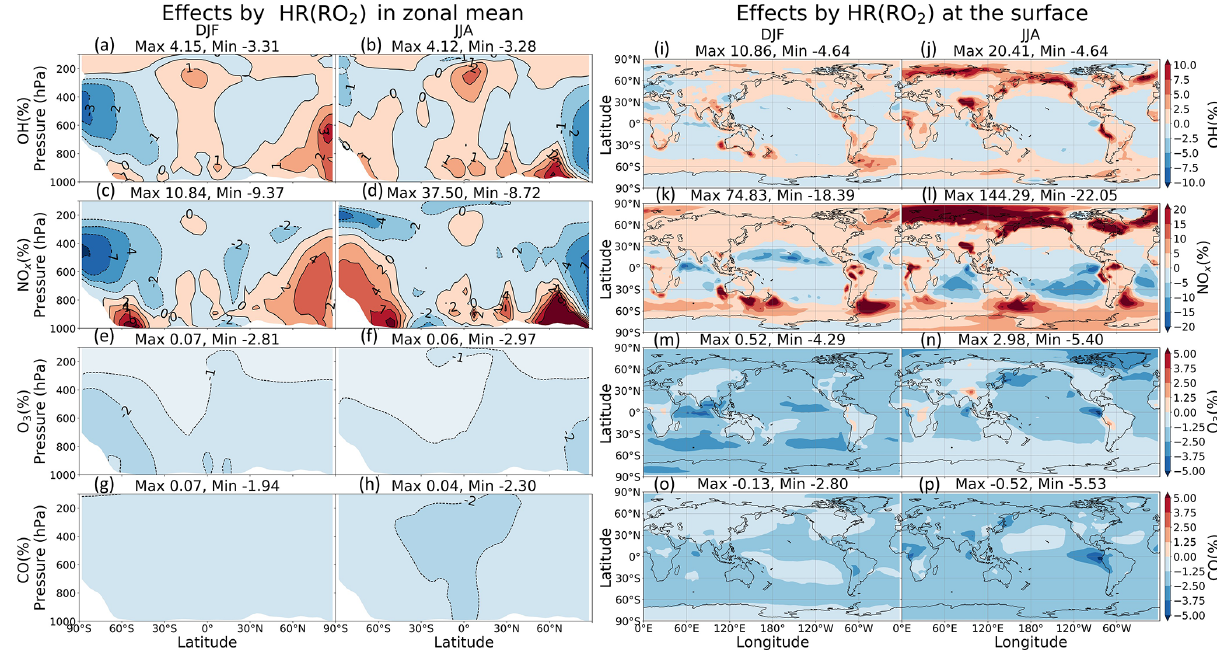
Figure 12. Effects of HR(RO 2 ) on both clouds and aerosols in the zonal mean (a–h) and at the surface layer (i–p) . Note that the color scale for (a) – (h) is different from that for (i) – (p)